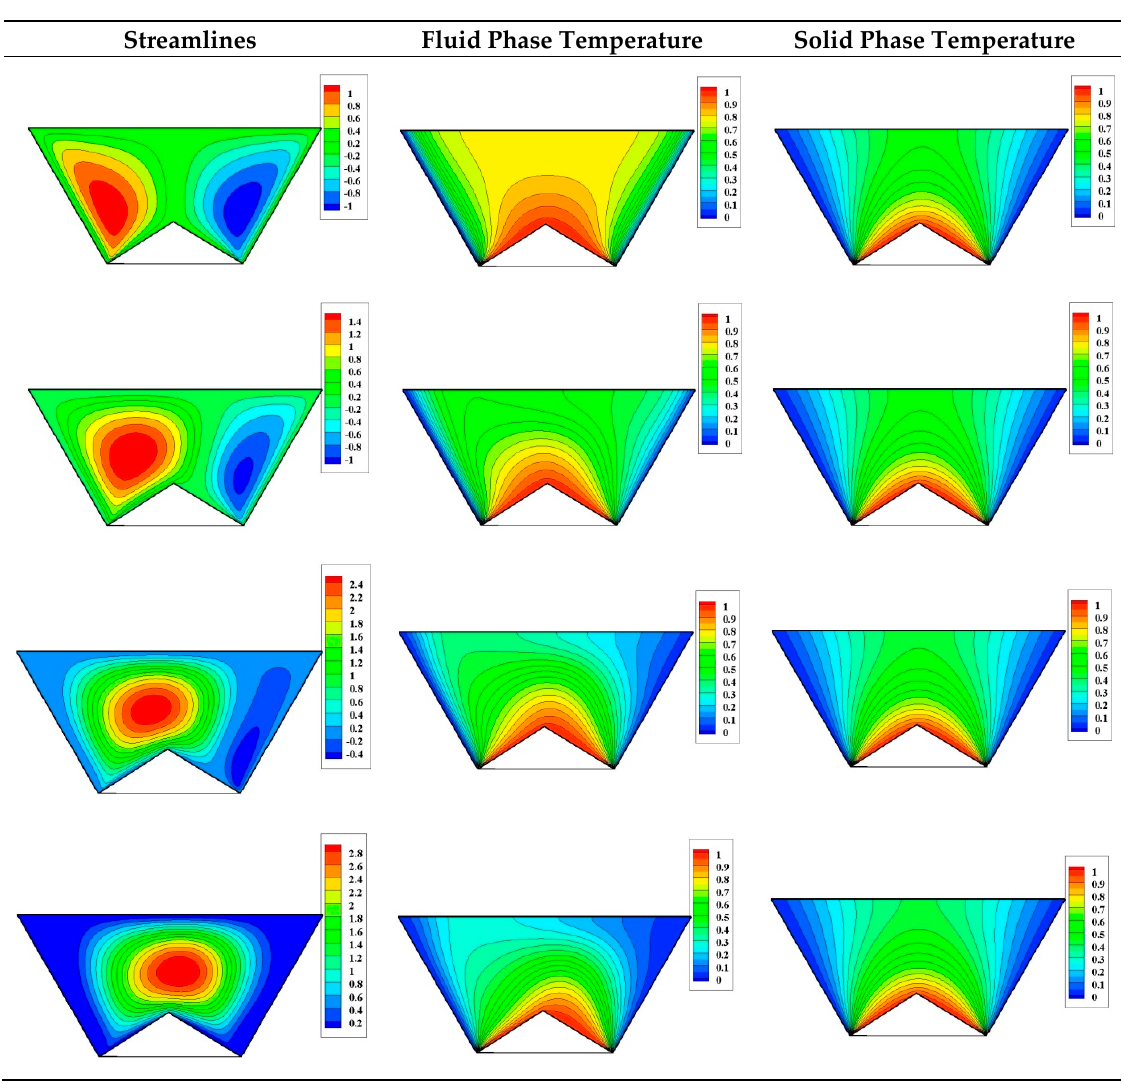
Figure 4. Features of the streamlines and temperature distributions for the fluid phase and porous phase for the variation of the inclination angle γ ( γ = 0, π